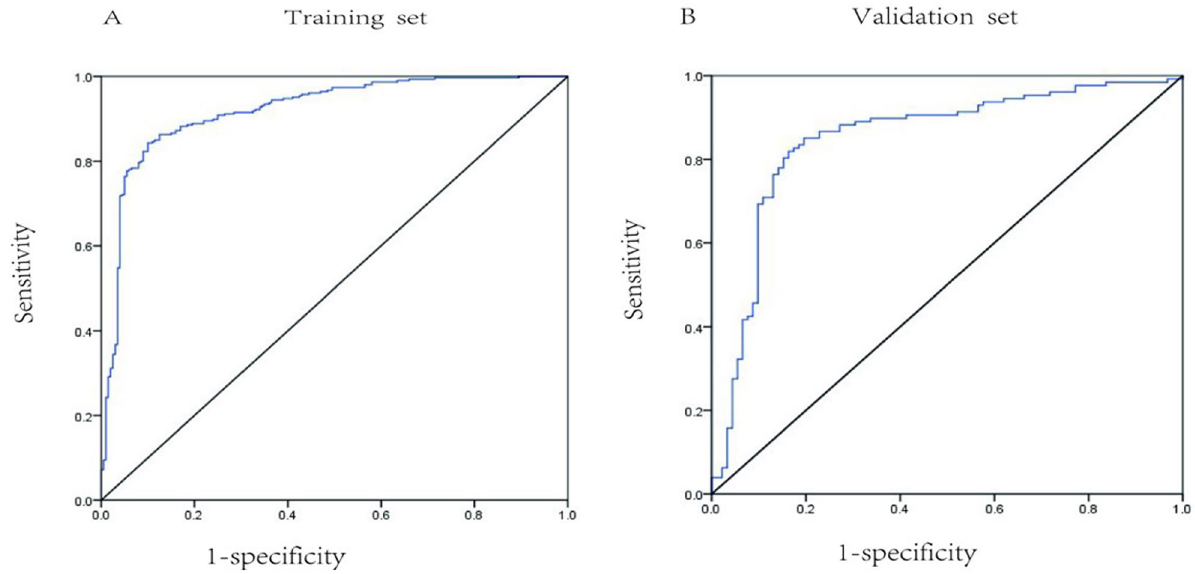
Figure 2. ROC curve of logistic regression modeling for predicting IgAN. ( A ) Area under the ROC curves were 0.92 in training set. ( B ) Area under the ROC curves were 0.839 in validation